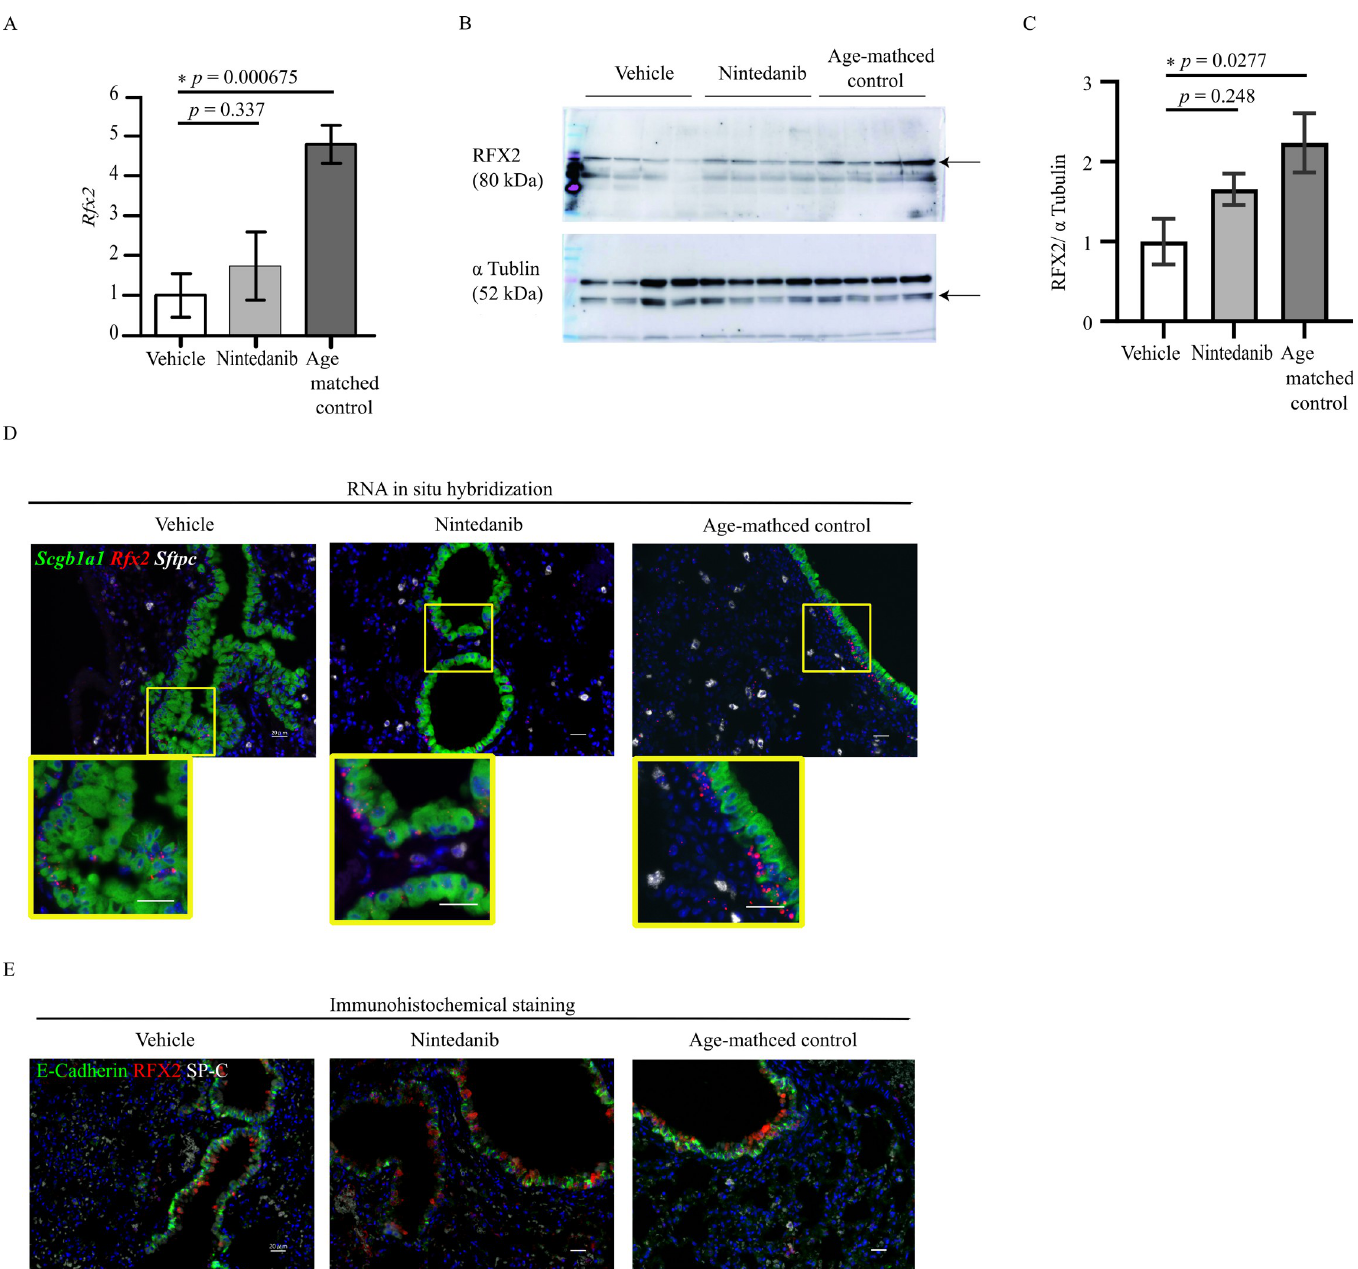
Fig 4. Rfx2 expression in lung. (A–C) Rfx2 expression in vehicle-treated, nintedanib-treated, and age-matched lung tissue. (A) Quantitative reverse transcription polymerase chain reaction analysis showed that Rfx2 expression was significantly downregulated in vehicle-treated mouse lung (n = 3) compared with that in age-matched D1CC × D1BB mouse lung (n = 3), and that this downregulation tended to be attenuated by nintedanib treatment (n = 3). The vehicle- and nintedanib-treated mouse lungs were obtained from the mice used in the analysis shown in Fig 1C. (B, C) Western blot analysis confirmed the findings shown in (A): age-matched D1CC × D1BB mouse lung, n = 4; vehicle-treated mouse lung, n = 4; nintedanib-treated mouse lung, n = 4 Relative signal intensity was determined using α Tubulin as the loading control. Data are presented as mean ± standard error. � , p < 0.05 by Dunnett’s test. (D) RNA in situ hybridization for Rfx2 revealed that Rfx2 was expressed strongly and weakly in cells adjacent to Scgb1a1 -positive cells and in some type I and type II alveolar epithelial cells, respectively. Sftpc and Scgb1a1 transcripts were used as an RNA-expression marker for type II alveolar cells and airway secreting cells, respectively. Scale bars = 20 μ m. (E) Immunohistochemical staining revealed that RFX2 (red) was localized mainly in bronchial epithelium and somewhat in alveolar epithelium. The expressions of E-cadherin (green) and SP-C (white) were used as a marker for epithelial cells, and epithelial cells and type II alveolar epithelial cells, respectively. Scale bars = 20 μ m.